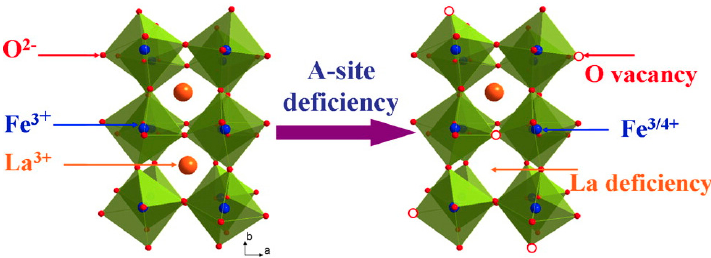
Figure 21. Formation of oxygen vacancies and Fe 4+ in enhancing the OER activity in A ‐ site ‐ deficient La 0.95 FeO 3 −δ perovskites. Reproduced from [60], with permission from the American Chemical Society, copyright 2016.